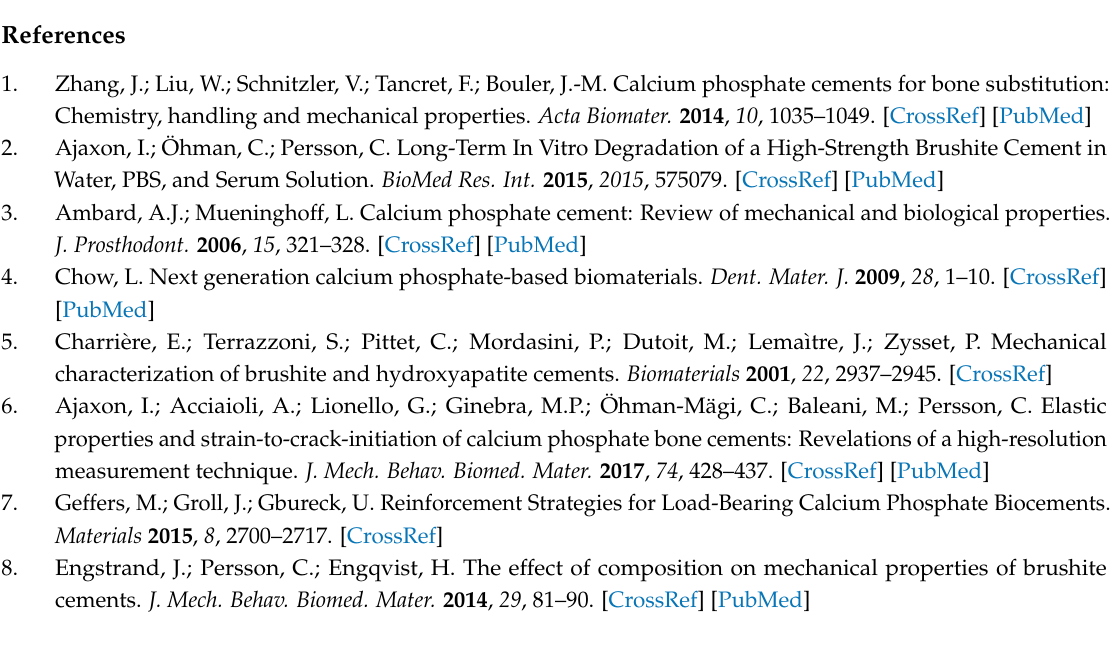
Figure S1: Errors in a zero-strain map achieved using a subset size of 60 × 60 pixels with different overlap values and strain window dimensions (error bar = standard